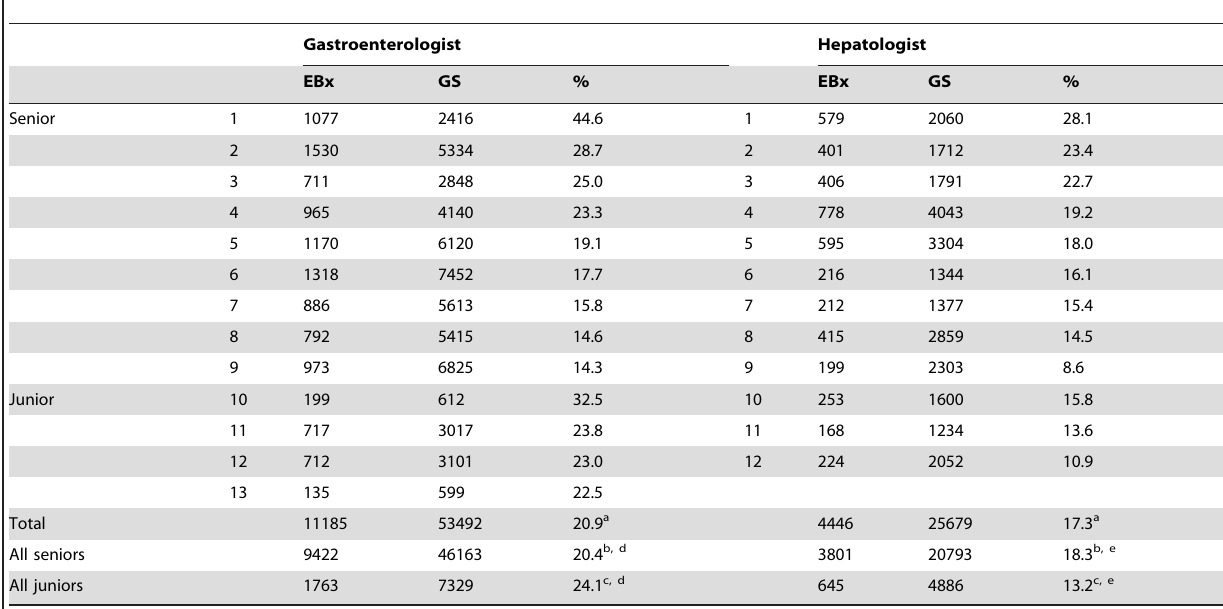
Table 3. The 5-year endoscopic biopsy/gastroendoscopy ratio of the 25 endoscopists including 13 gastroenterologists and 12 hepatologists and the distribution of senior and junior physicians in our